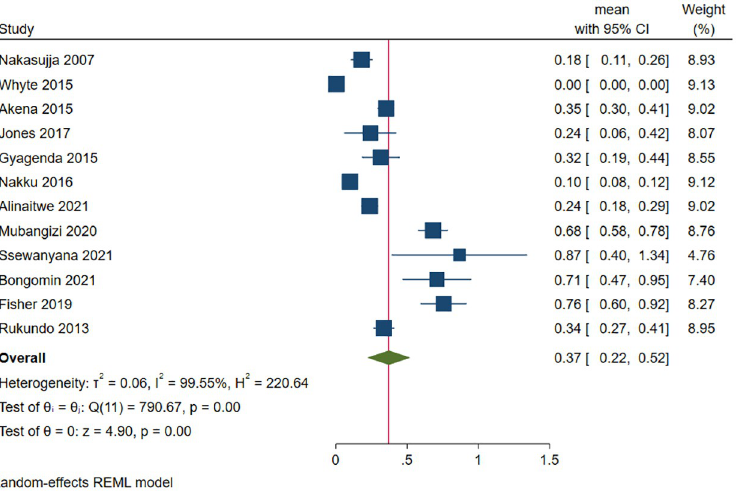
Fig 8. Forest plot on the prevalence of depression among special patient groups in Uganda.